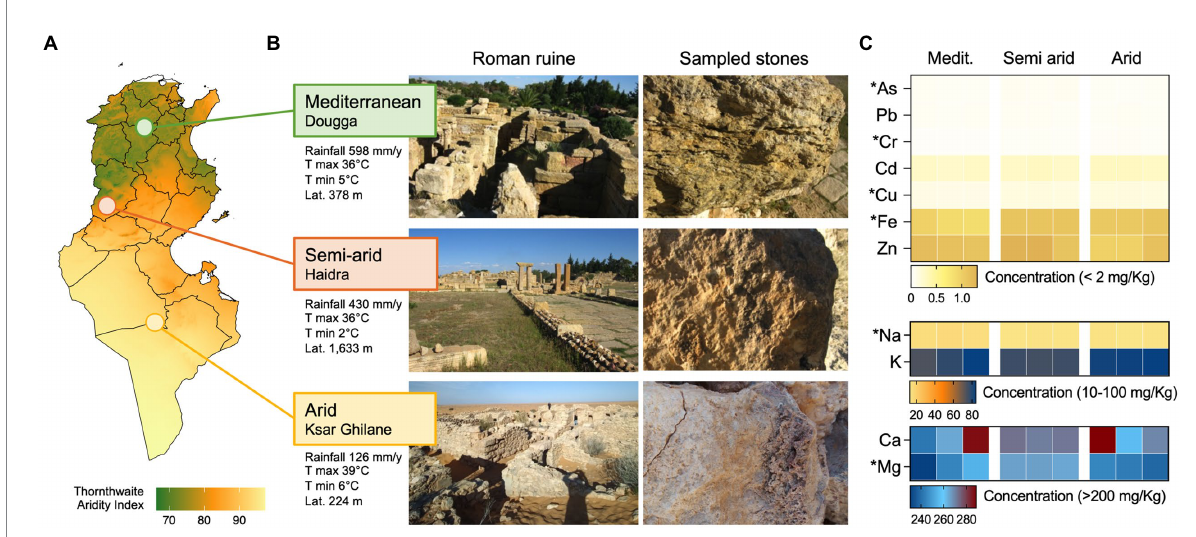
FIGURE 1 Ruins and climatic conditions along the aridity transect. (A) Map showing level of aridity in Tunisia expressed as Thornthwaite aridity index; the three sampling locations, namely Dougga, Haidra, and Ksar Ghilane, are indicated in the map and are categorized as Mediterranean, semiarid, and arid climates, respectively. (B) Representative images of the ruins and sampled stones in the three heritage sites. Climatic conditions of the three sites are also reported as average rainfall (mm/year), average max and min temperature ( ° C), and altitude (m). (C) The heat map reports the concentration (mg/kg) of stone elements along the aridity transect, namely the Mediterranean, semiarid, and arid climates. The elements are divided based on concentration ranges (<2 mg/kg, 10–100 mg/kg, and > 200 mg/kg) and their content is shown for each of the three replicates collected from each